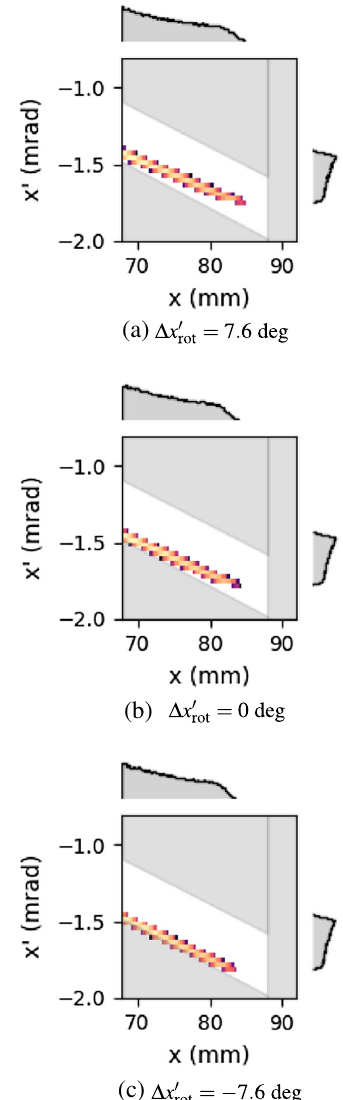
FIG. 8. Extracted beam in phase space on the high-field side upstream of the ZS simulated with different values of the resonance driving term rotation knob applied with the nominal LSE strength and extraction bump